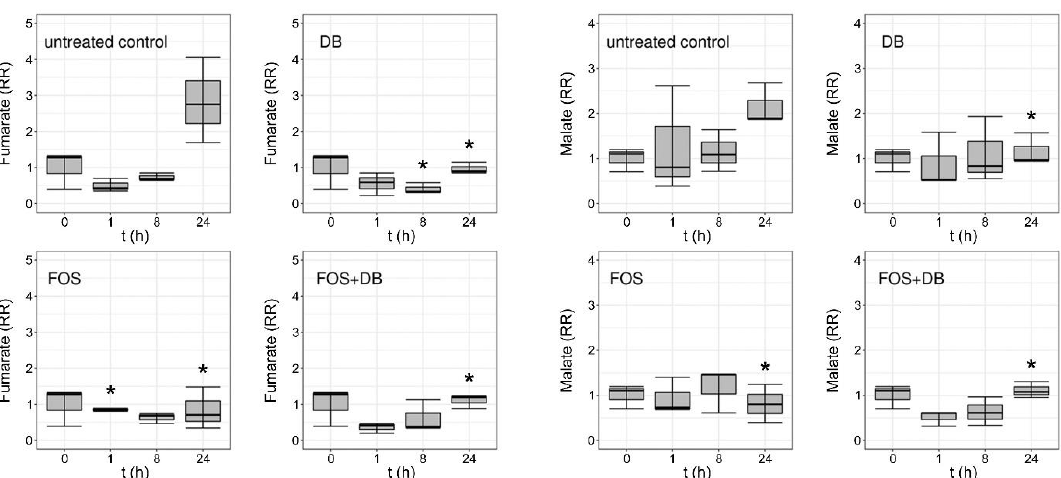
Figure 5. Relative amounts of pyruvate and citric acid cycle intermediates in extracts at different times of P. falciparum cultures treated with 20 µM DB and fosmidomycin, individually and combined. RR: relative response. *: p < 0.05; **: p < 0.005; ***: p < 0.0005.